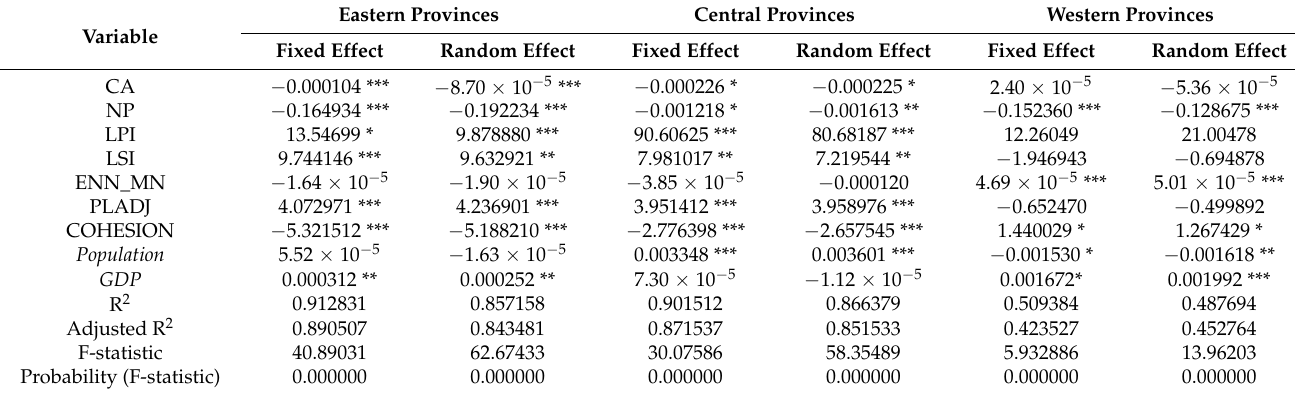
Table 6. The relationships between the UF and PM 2.5 concentration in the different regions at the provincial scale. Eastern Provinces Central Provinces Western Variable